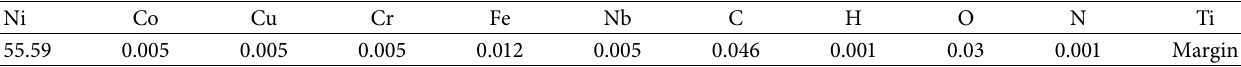
Table 1: Chemical composition.